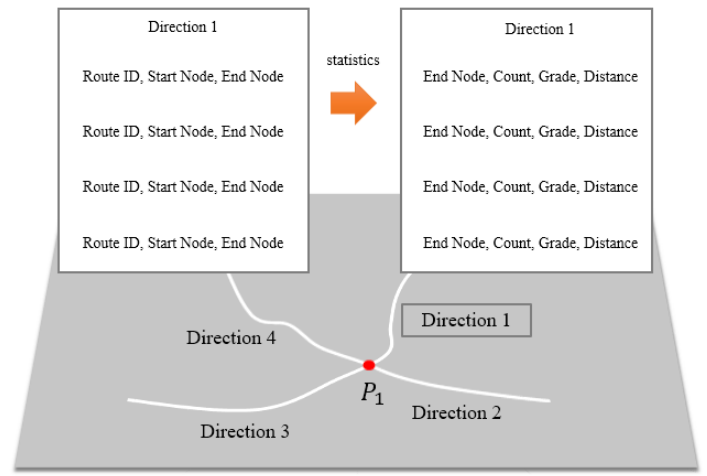
Figure 6. The statistical process of recording simulated route information of a junction node.